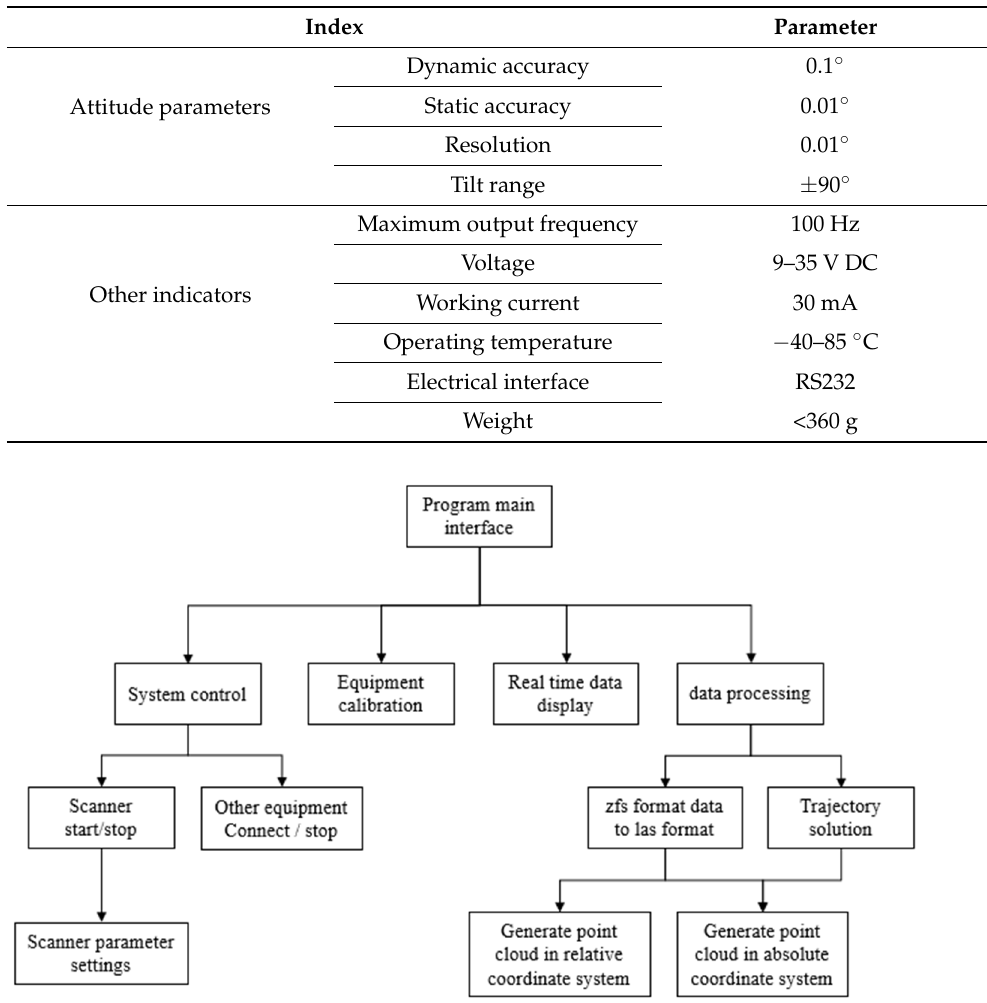
Figure 9. Program interface. 3.1.3. System Calibration To complete the spatial synchronization of each TMLS sensor, we used a method of system calibration to unify the spatial coordinate system. By calibrating the scanner, the relative position between the scanner center and the car body was obtained, and the scan- ner coordinate system and the car body coordinate system were unified. By calibrating the IMU, the attitude angle error between IMU and the car body in the engineering coor- dinate system was obtained, and the IMU coordinate system and the car body coordinate system were unified. To prevent the horizontal attitude angle of IMU and zero-degree value of angle measurement of the inclinometer from being parallel to the horizontal plane and closure error of the IMU heading angle [24], the zero-degree deviation of horizontal inclination and the closure error of the heading angle were calibrated.